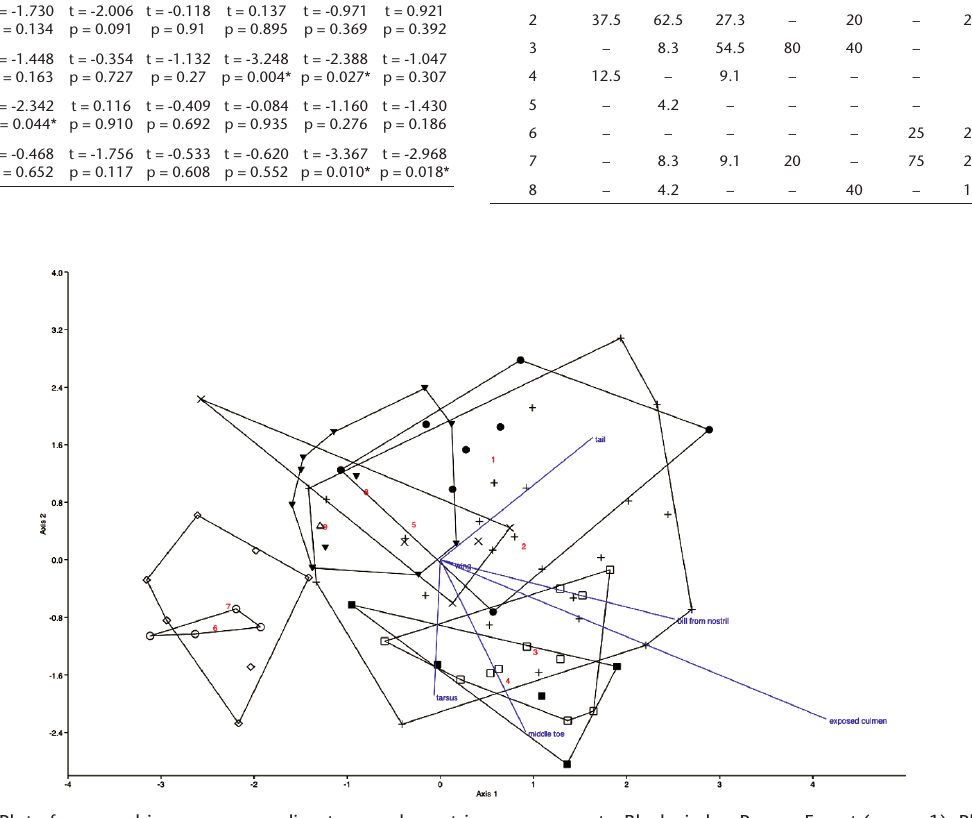
Figure 3. CVA Plot of geographic groups according to morphometric measurements. Black circles: Parana Forest (group 1); Plus: Atlantic Forest 1 (group 2); White squares: Atlantic Forest 2 (group 3); Black squares: Atlantic Forest 3 (group 4); Exes: Araucaria Forest 1 (group 5); White circles: Araucaria Forest 2 (group 6); White diamonds: Pampa (group 7); Inverted black triangles: Chaco (group 8); White triangle: Yungas (group